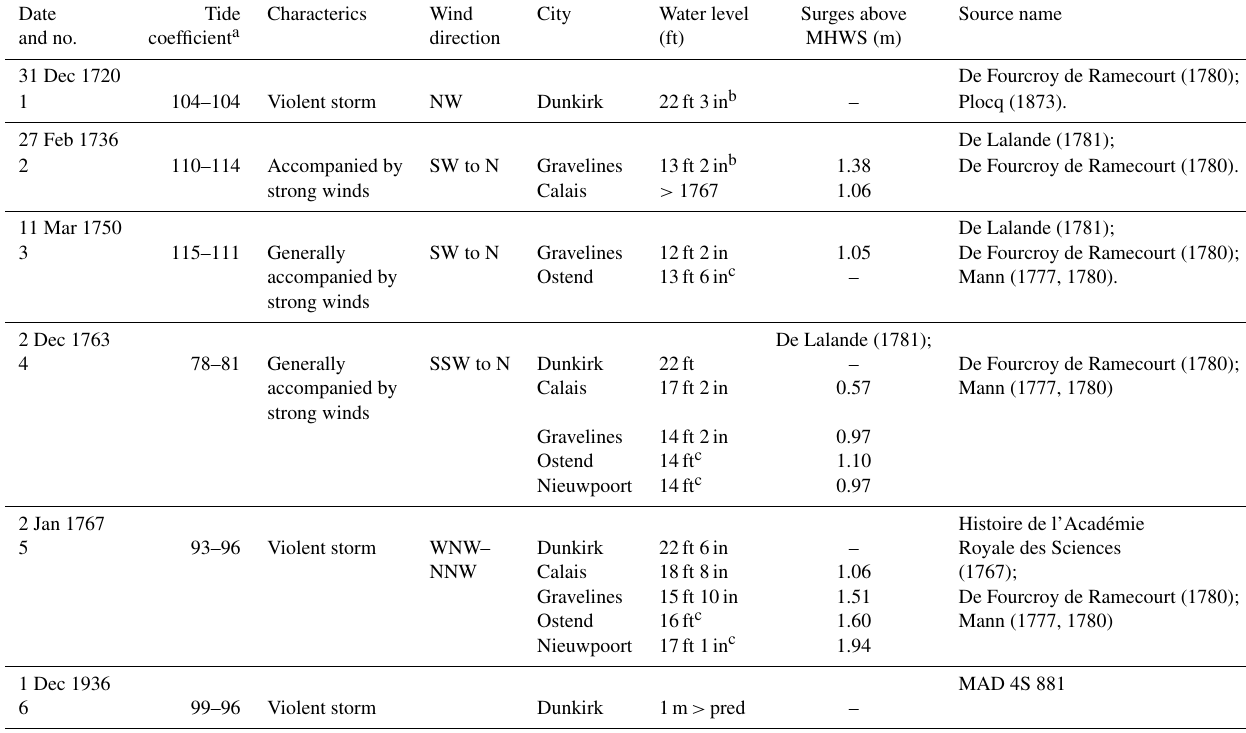
Table 3. HI about water levels in Dunkirk and other cities (unless otherwise stated, Heights are given in French royal foot which corresponds to 0.325m).